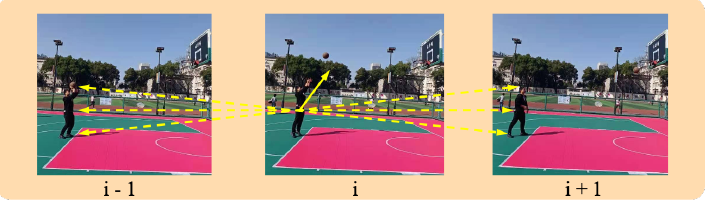
Figure 6. Connections between consecutive multi-frames. From the figure, we find that the current action i is not only affected by its own state, but may also be affected by its predecessor action i − 1 and subsequent action i + 1. Therefore, if the connection between the frames of the image sequence can be captured, it is possible to improve the accuracy of human action